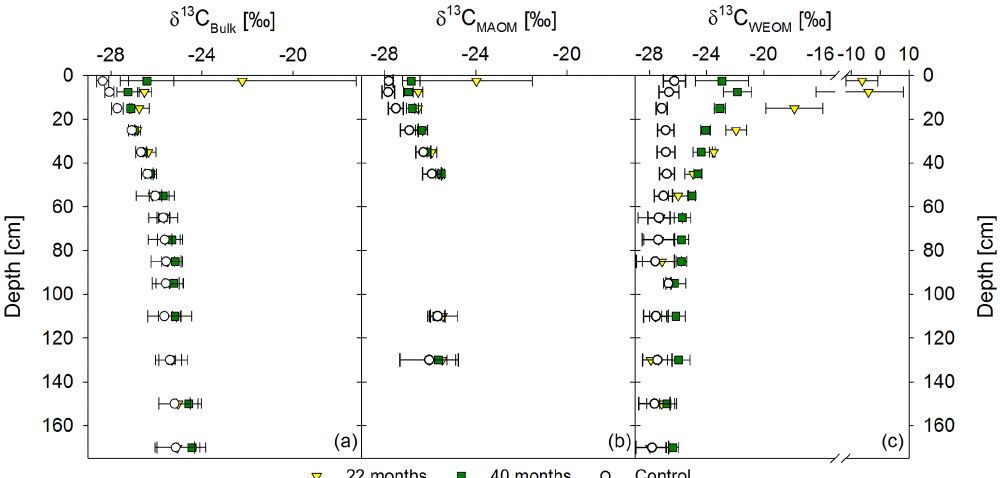
Figure 5. Mean δ 13 C values of the bulk soil (a) , mineral-associated OM (C MAOM ) (b) , and water-extractable OM (C WEOM ) (c) . The graphs show labeled samples of both sampling times, 22 and 40 months after labeled litter application, in colored symbols, compared to the respective unlabeled background distribution in white symbols. Labeled samples represent the mean of three replicates per sampling time, while the control represents the mean of both sampling times ( n = 6). Please note that the x axis in (c) has a different scale.